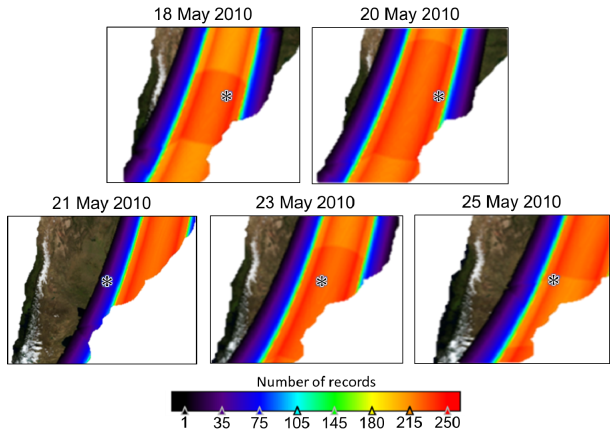
Figure 1. Number of TB records across the swath for a period of 8 days – from 18 to 25 May 2010 – over the area of La Plata, Ar-